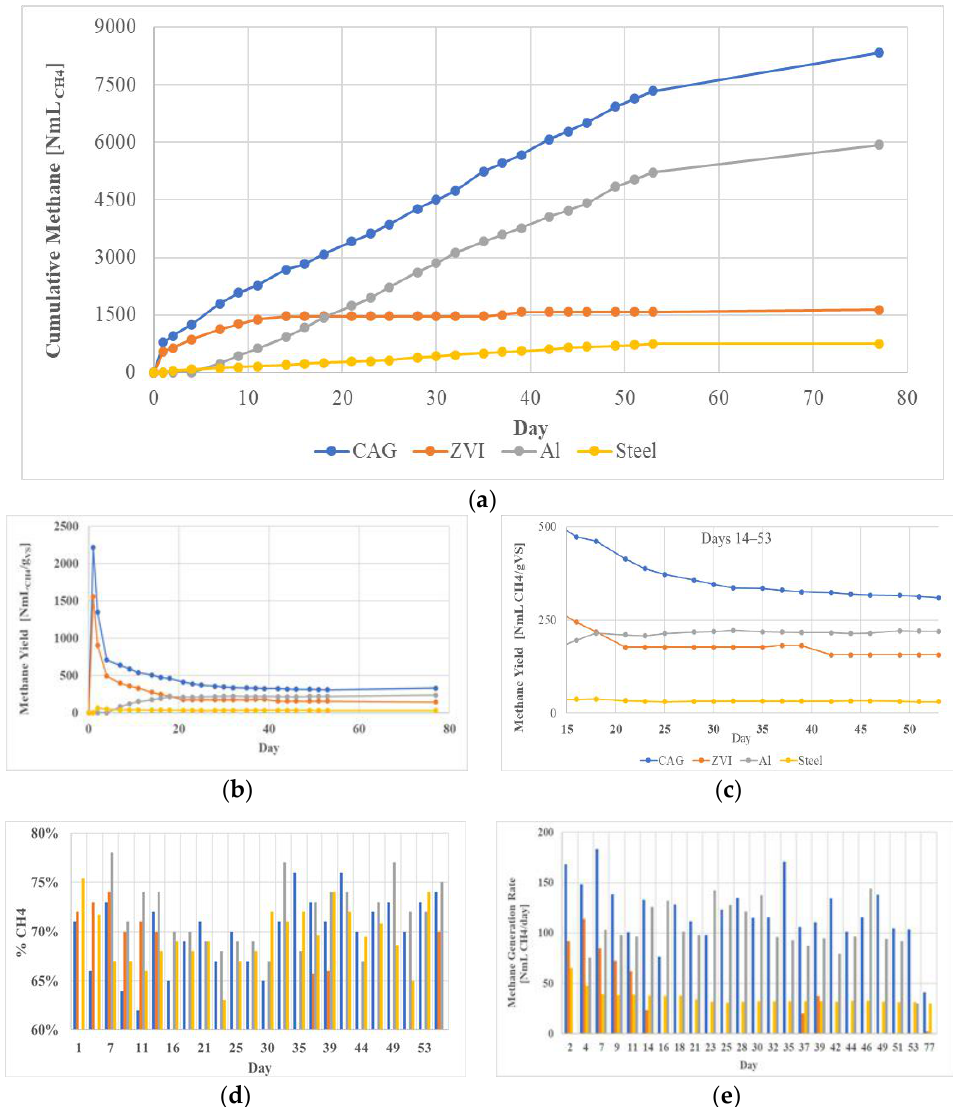
Figure 3. Cumulated specific methane production ( a ), specific methane yield ( b ), specific methane yield for the regime phase (days 14–53) ( c ); %CH4 in biogas ( d ) and daily generation rate ( e ) during the semi-continuous tests. The color codes are always the same for all figures.